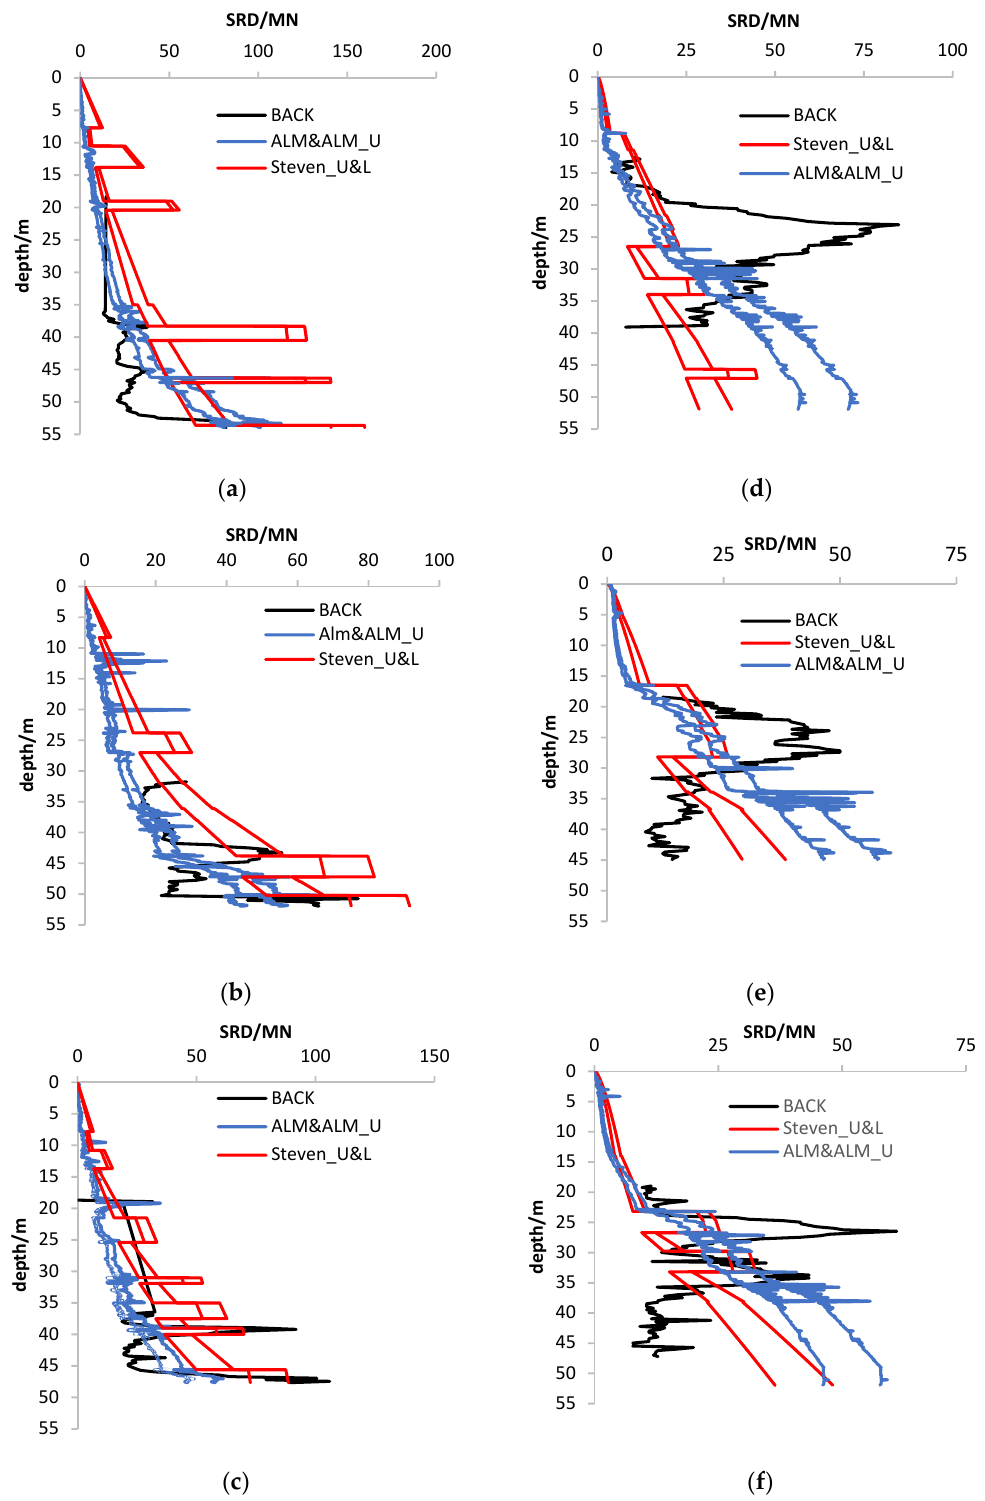
Figure 3. Comparison of SRD obtained by back analysis and that obtained using the Steven and Alm methods. ( a ) Case 1 (a); ( b ) Case 1 (b); ( c ) Case 1 (c); ( d ) Case 2 (a); ( e ) Case 2 (b); ( f ) Case 2 (c).